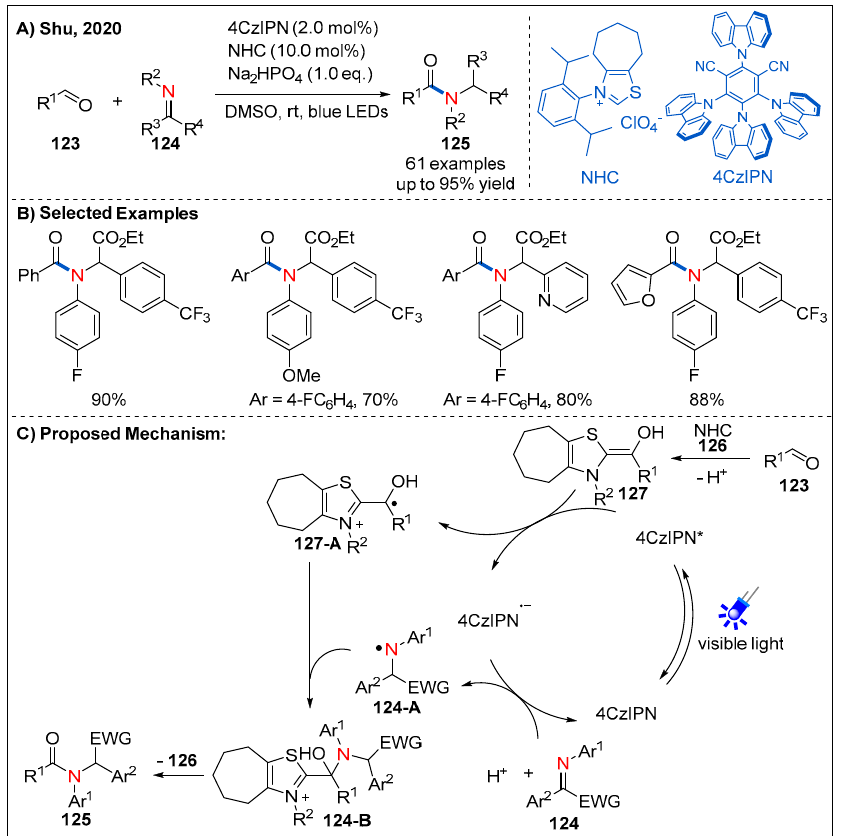
Figure 37. Visible-light-driven dual photoredox and N-heterocyclic carbene-catalyzed C-N bond- forming reaction for amide synthesis from aldehydes and imines.